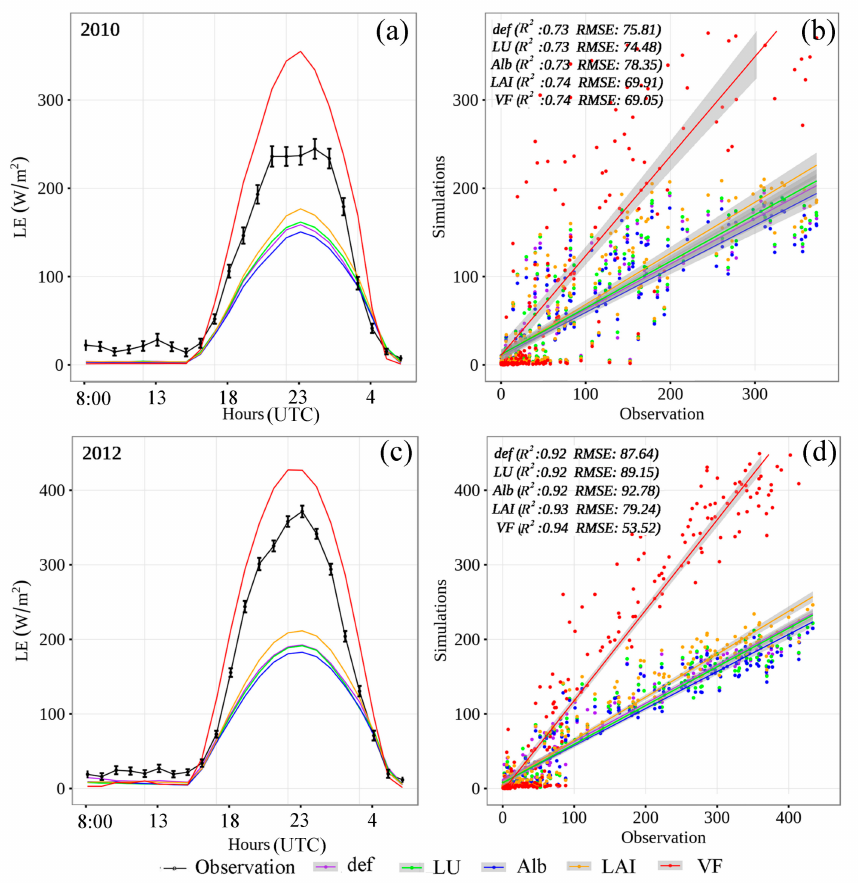
Figure 3. Comparisons of hourly averaged latent heat flux (LE) between observations and five simulations, and corresponding scatter diagram at the S2 site in ( a , b ) 2010 and ( c , d ) 2012. The five simulations are as follows: def (using default LU, albedo, LAI, and VF data); LU (using actual LU data), Alb (using actual LU and albedo data), LAI (using actual LU, albedo, and LAI), and VF (using all of actual LU, albedo, LAI, and VF